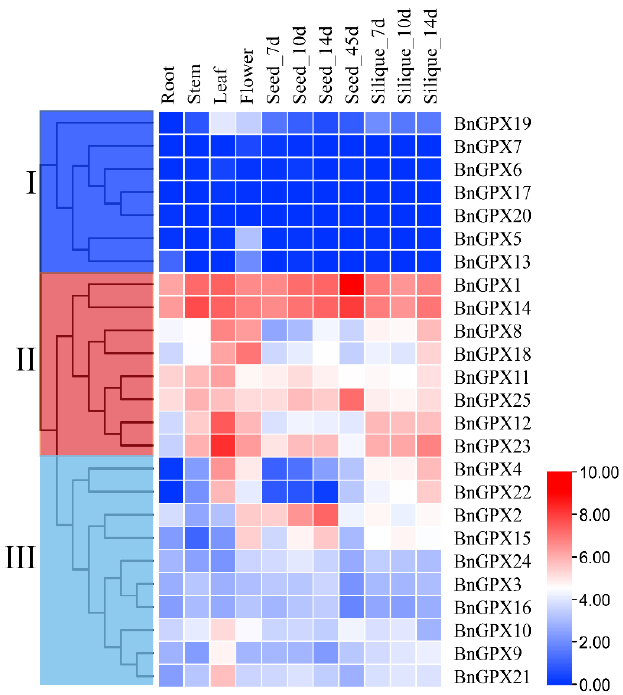
Figure 7. Expression profiles of BnGPX genes in numerous tissues at different growth stages of rapeseed. The 7d, 10d, 14d, and 45d tags indicated the time-points when the samples were harvested. The red color indicates high and the blue color indicates low expression levels. The expression heat map was generated based on transcripts per million (TPM) values.